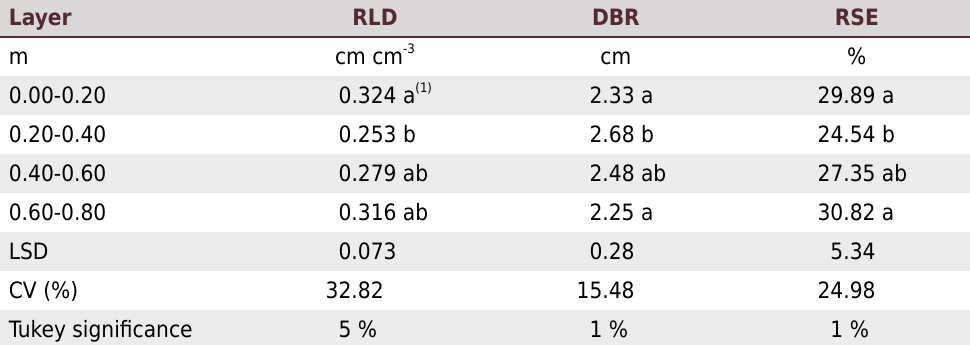
Table 4. Root length density (RLD), proportional distribution of roots (RD), average distance between roots (DBR), and root soil exploration (RSE) in sugarcane after the 1st harvest in an area of sugarcane crop renewal at different